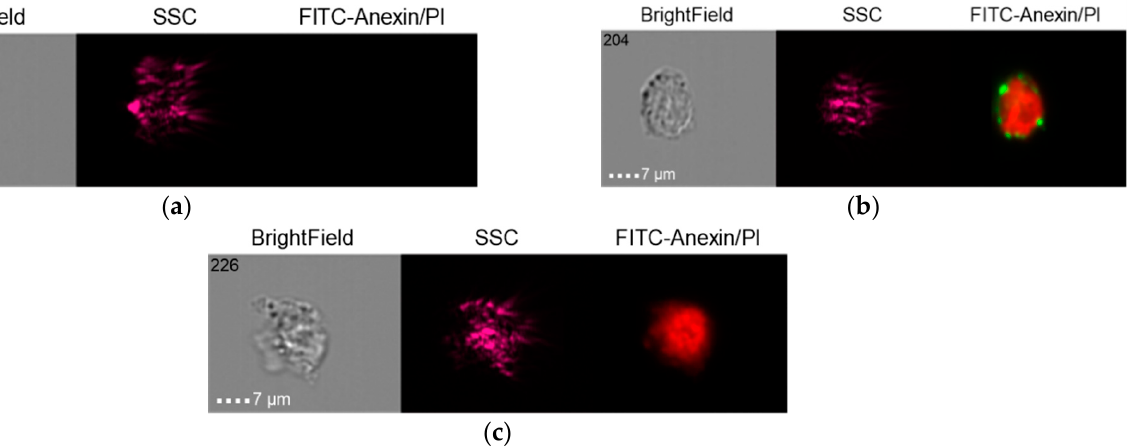
Figure 15. Live cells ( a ), late apoptosis ( b ), necrosis ( c ) after co-culture of THP-1 cell line with Nobel Replace NSMP induced by lipopolysaccharide (Nobel Replace NSMP + HDS + LPS + THP-1).